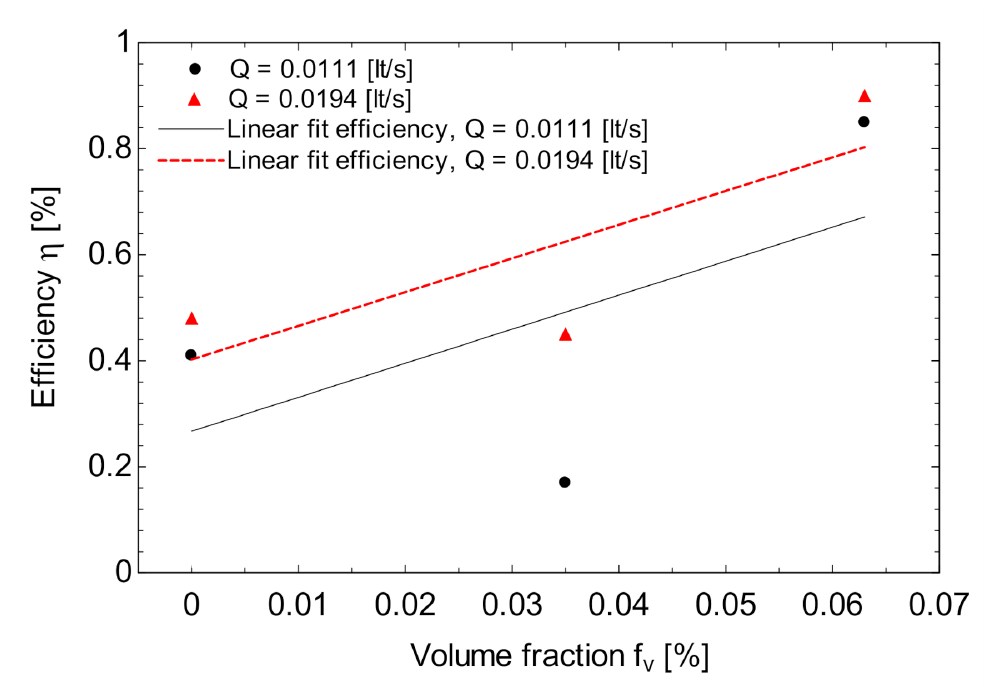
Figure 15. Efficiency of the CSAD using Fullerenes C60, with respect to the concentration at two flow